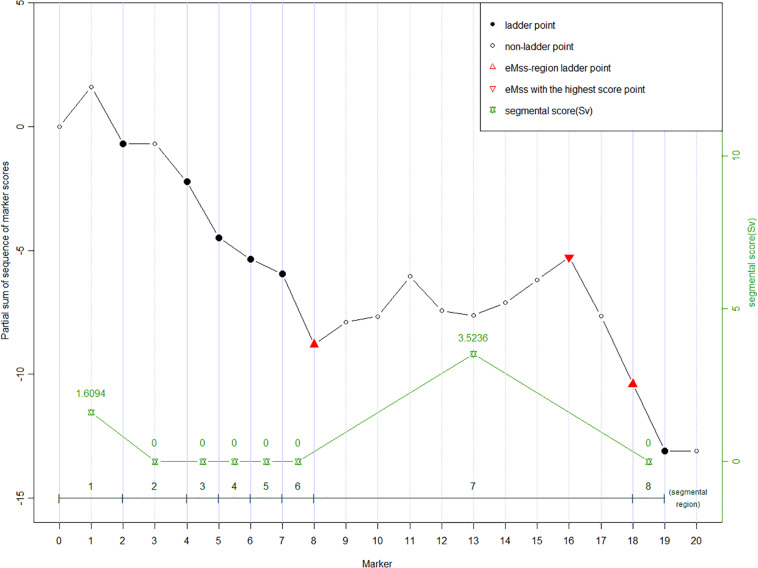
An example of partial sum scores for 20 SNPs. Ladder points in solid dots (2nd, 4th to 8th, 18th, and 19th SNP) forming eight segmental regions are the markers with new record lows of the partial sum scores, which are lower than all scores on their left, respectively. The ladder points partition the curve into the up-climbing intervals (e.g., [0 to 2nd], [2nd to 4th], and [8th to 18th]), which indicate the cluster of neighboring significant SNPs and the declining regions (the rest insignificant intervals). Segmental score (Sv, green stars) is the vertical height of each interval, and the highest Sv is assumed to be the most susceptive region. In eMSS, some minor number of insignificant SNPs within the susceptive region are tolerable, e.g., markers 12 and 13.